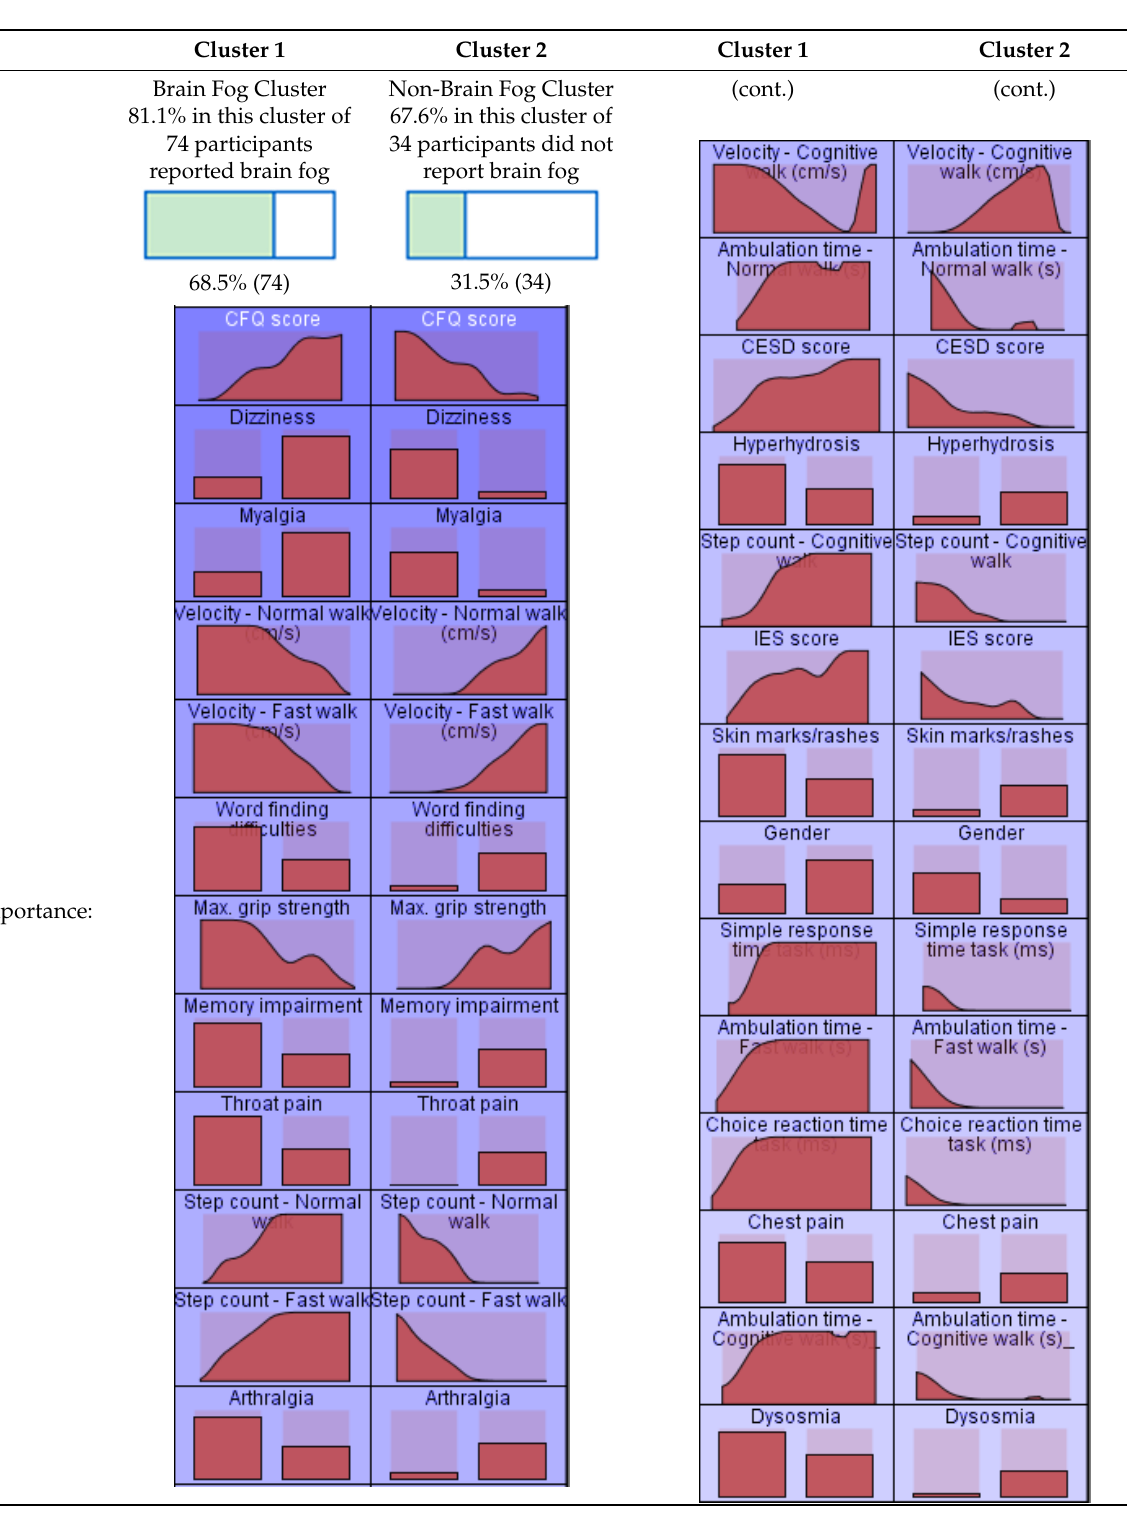
Table A1. Results of the automatic cluster analysis to rank the importance of brain fog associations. A visual display of the relative distributions of input variables by decreasing importance score was obtained.